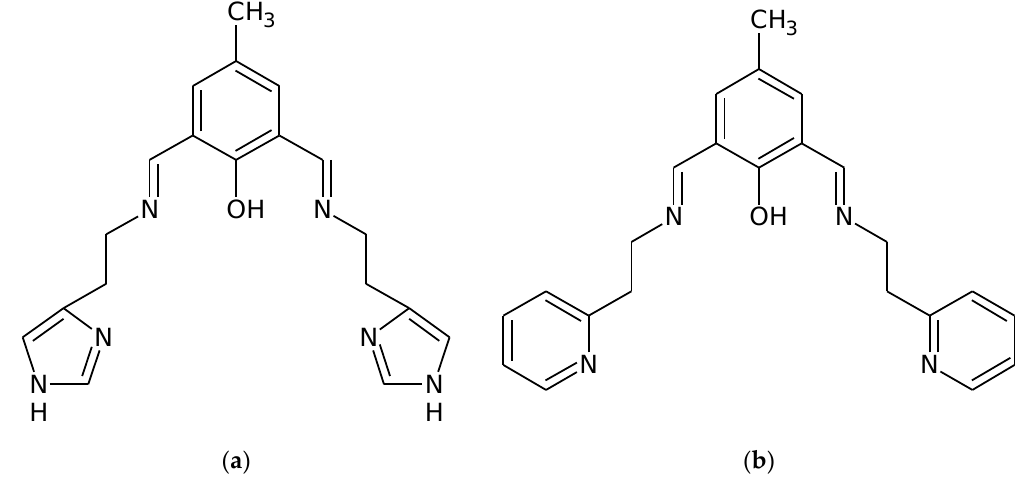
Figure 1. Chemical structures of ( a ) HL1 and ( b ) HL2 .